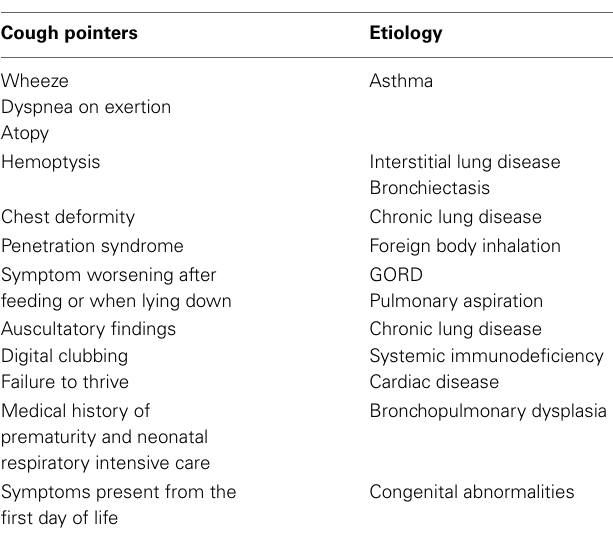
Table 2 | Cough pointers and